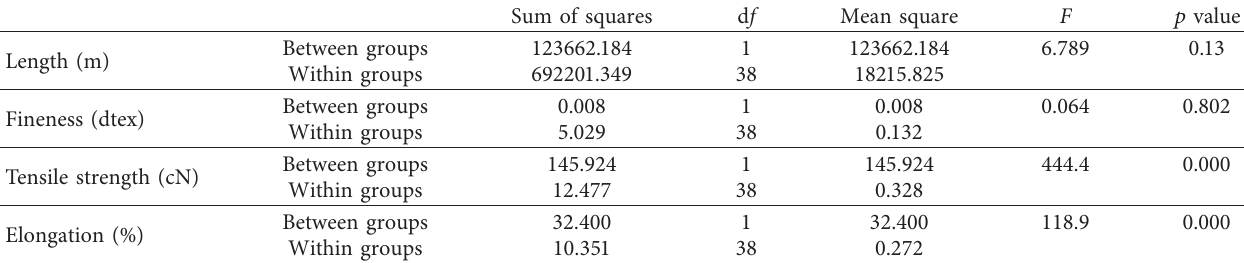
Table 2: Analysis of variance of mulberry silk fibres.